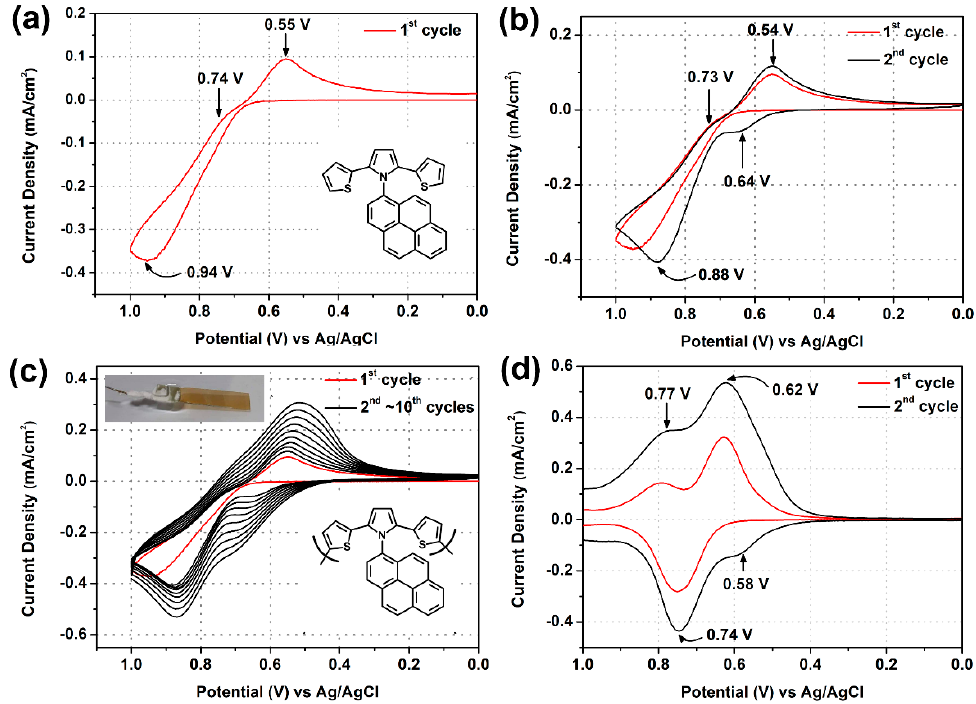
Figure 2. ( a ) The first CV scan, ( b ) the first two CV scans, and ( c ) ten repetitive CV scans of 1 mM of Py-SNS in 0.1 M TBAP/MeCN in the potential range of 0.00–1.00 V at a scan rate of 50 mV/s. ( d ): DPV scans at scan rate of 5 mV/s.